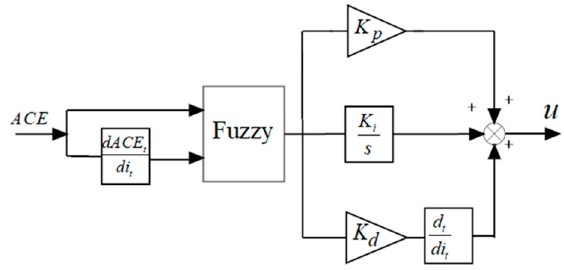
Figure 3. A schematic diagram of the fuzzy tuning.